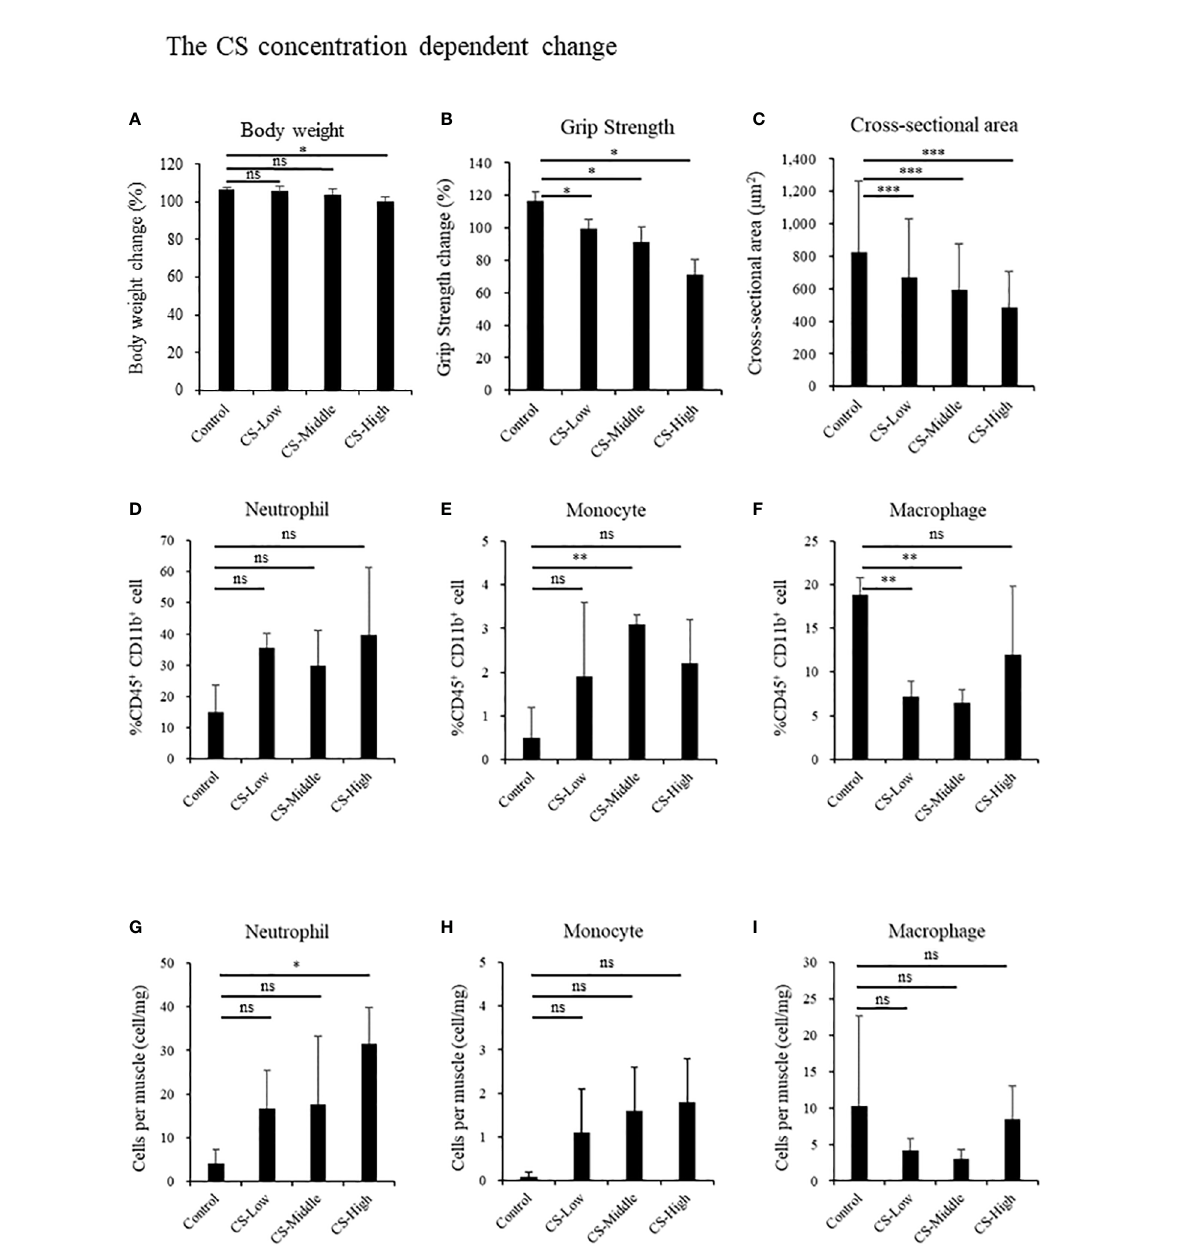
FIGURE 3 Sepsis induces neutrophil in fi ltration, muscle atrophy, and weakness by CS-dose dependent manner in mice. Body weight, grip strength, and the cross-sectional area of the tibialis anterior muscle, and immune effector cells at day 14 in the different concentrations of low: 0.3 mg/g (n = 3), middle: 1.0 mg/g (n = 3), high: 2.0 mg/g (n = 4). (A) Body weight, (B) Grip strength, (C) Cross-sectional area of the tibialis anterior muscle, percentages of (D) Neutrophils, (E) Monocyte, (F) Macrophage, population of (G) Neutrophils, (H) Monocyte, (I) Macrophage. Statistical signi fi cance versus control at * P < 0.05, ** p < 0.01, *** p < 0.001, ns = not signi fi cant (p >